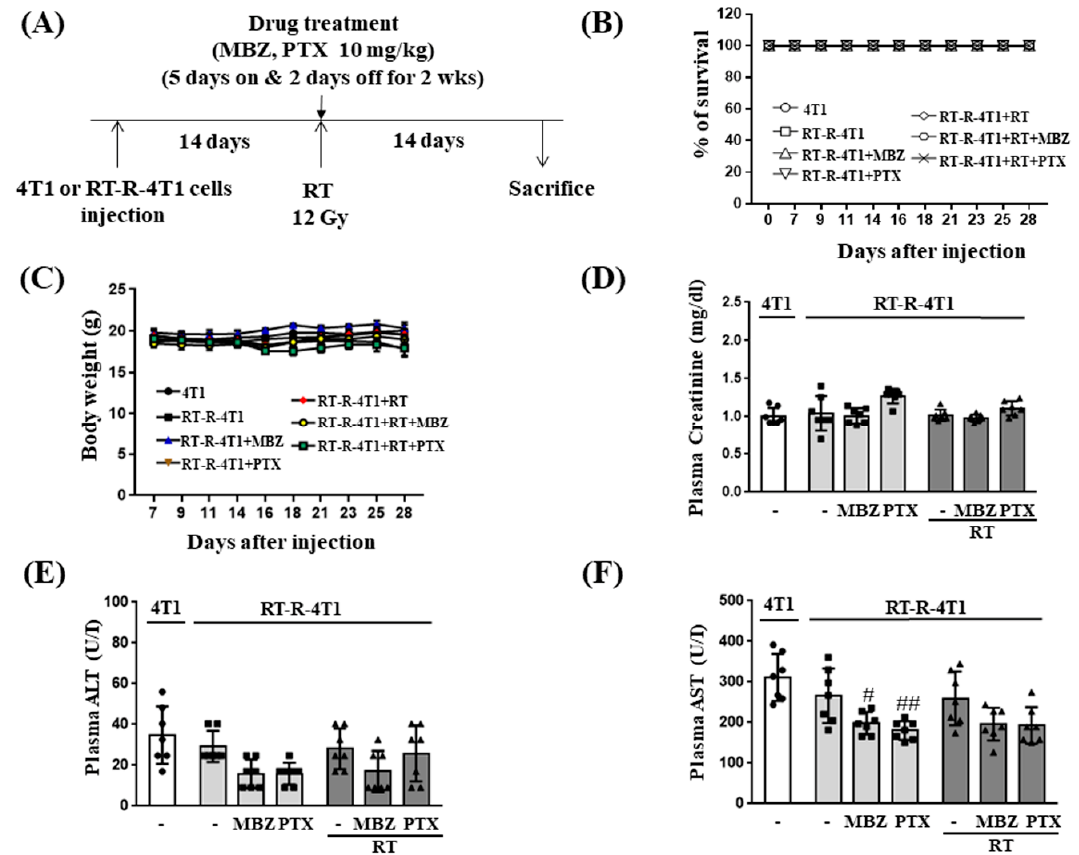
Figure 1. The combination of mebendazole (MBZ) and radiotherapy (RT) has no serious toxicity on RT-resistant-4T1 (RT-R-4T1) tumor allografts in athymic nude mice. ( A ) Experimental scheme for 4T1 and RT-R-4T1 allograft construction and drug treatment in athymic nude mice. 4T1 cells or RT-R-4T1 cells (5 × 10 4 cells/100 µ L) were injected into the right thighs and the mice were divided into 7 groups (n = 7 per group) on day 14 after injection; (1) mice injected with 4T1 cells (4T1 group), (2) mice injected with RT-R-4T1 cells (RT-R- 4T1 group), (3) RT-R-4T1 group + MBZ, (4) RT-R-4T1 group + paclitaxel (PTX), (5) RT-R-4T1 group + RT, (6) RT-R-4T1 group + RT + MBZ, (7) RT-R-4T1 group + RT + PTX. For RT, the mice were irradiated with a single dose of 12 Gy to the right thigh. MBZ (10 mg/kg) and PTX (10 mg/kg) were administered by oral gavage and intraperitoneal injection, respectively, on the same day before irradiation and thereafter daily for two consecutive weeks on a “5 days on and 2 days off” schedule. ( B , C ) Body weights and survival rate were measured three times a week for four weeks from day seven after the injection of cancer cells. The mice were killed on the 28th day after injection, and levels of ( D ) plasma creatinine, ( E ) alanine aminotransferase (ALT), and ( F ) aspartate aminotransferase (AST) were measured. The bar graph in white is for 4T1 cells, light gray is for RT-R-4T1 cell treated with MBZ or PTX alone, and dark gray is for RT-R-4T1 cell with RT combined treatment. The values are presented as the mean ± SD from five independent determinations ( # p < 0.05, ## p < 0.01 compared with the control of RT-R-4T1). After treatment with MBZ (10 mg/kg), PTX (10 mg/kg), and RT (12 Gy), tumor volumes and numbers of lung metastases were determined to establish the anticancer